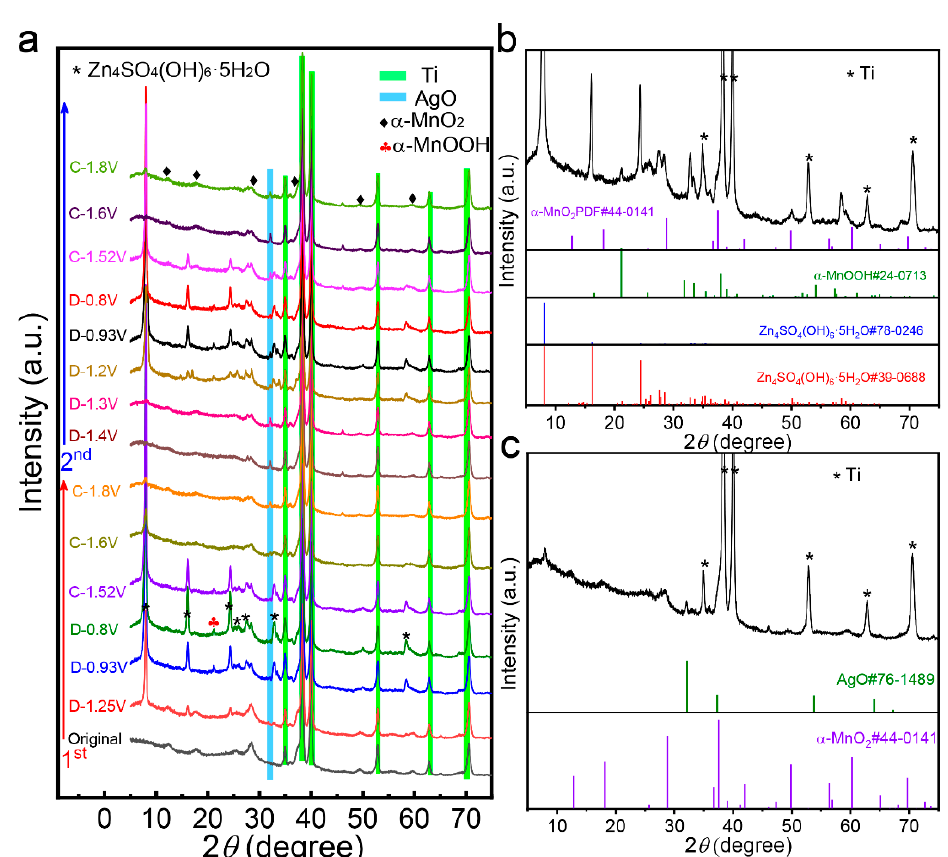
Figure 4. ( a ) Ex situ XRD patterns at different potentials of 5%Ag-MnO 2 during the initial two cycles. XRD pattern of 5%Ag-MnO 2 at full ( b ) discharged and ( c ) charged stage, where the standard XRD pattern is also provided.